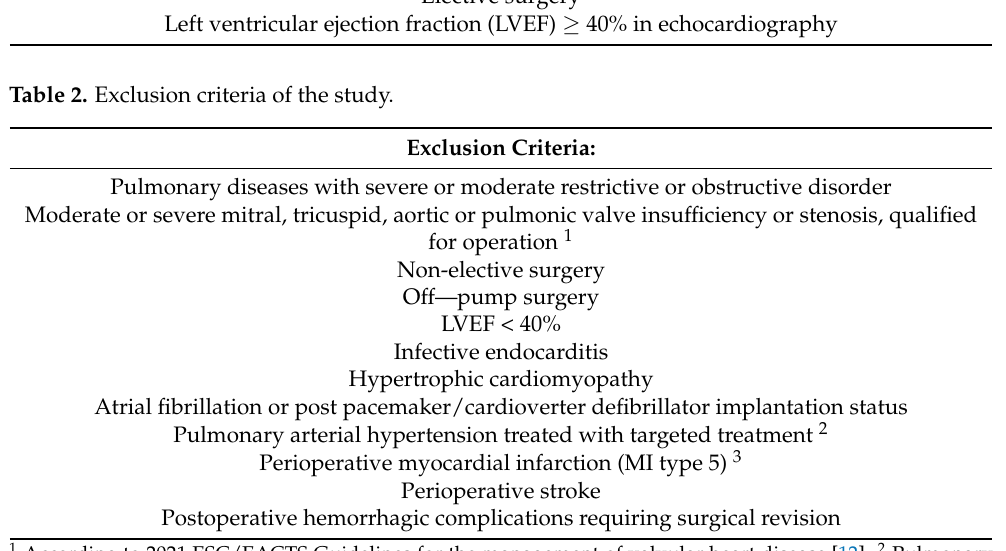
Table 2. Exclusion criteria of the study.